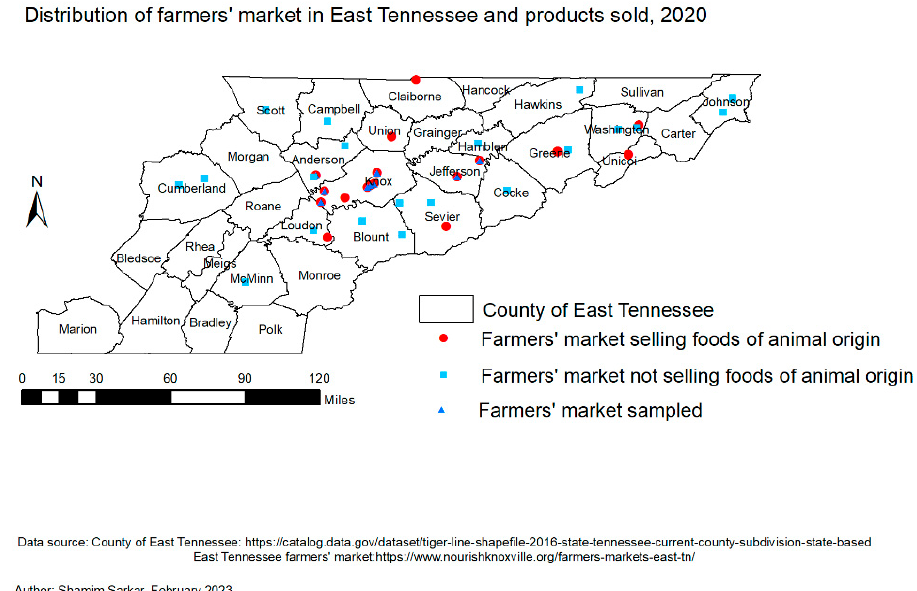
Figure 1. Map showing the distribution of farmers’ markets in East TN, those who do (n = 18) and do not sell (n = 23) foods of animal origin, and those from which purchased products (n = 9) were analyzed for antibiotic residues.